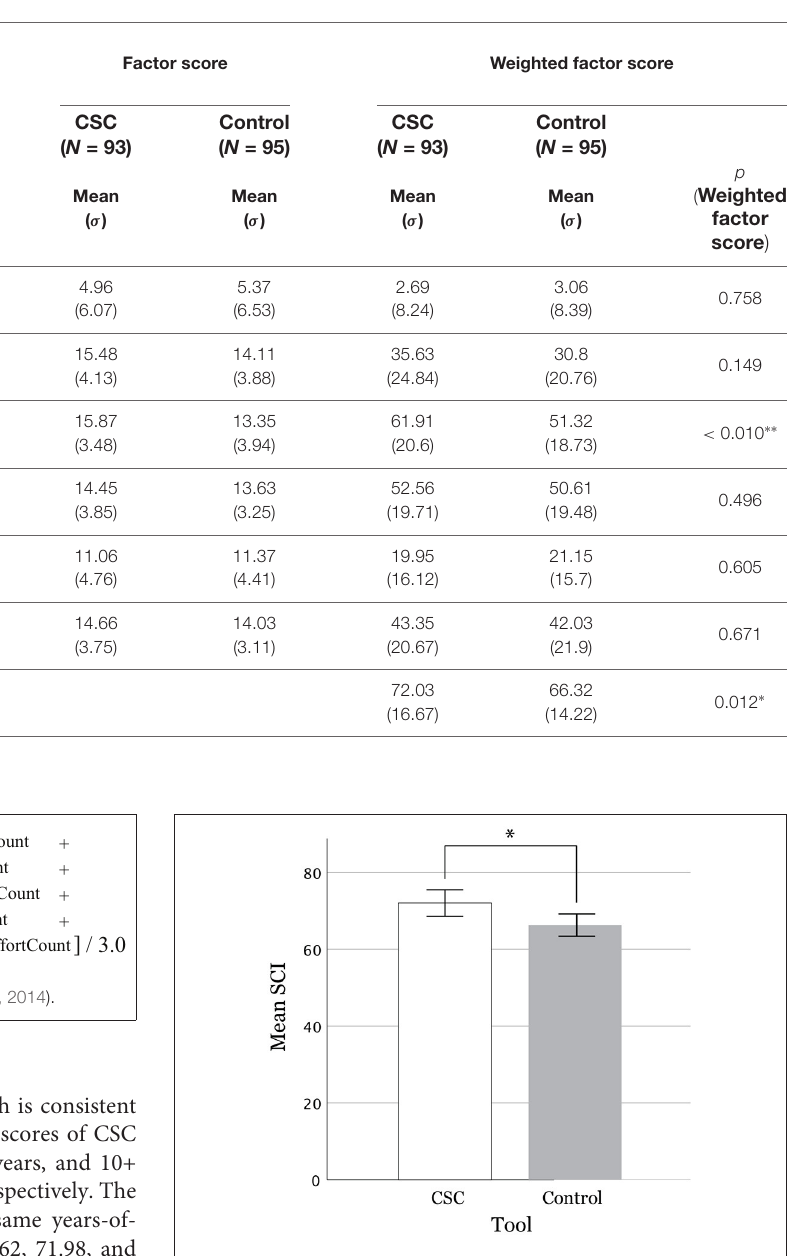
FIGURE 6 | CSI scores between experiment (CSC) group and Control group. * P ≤